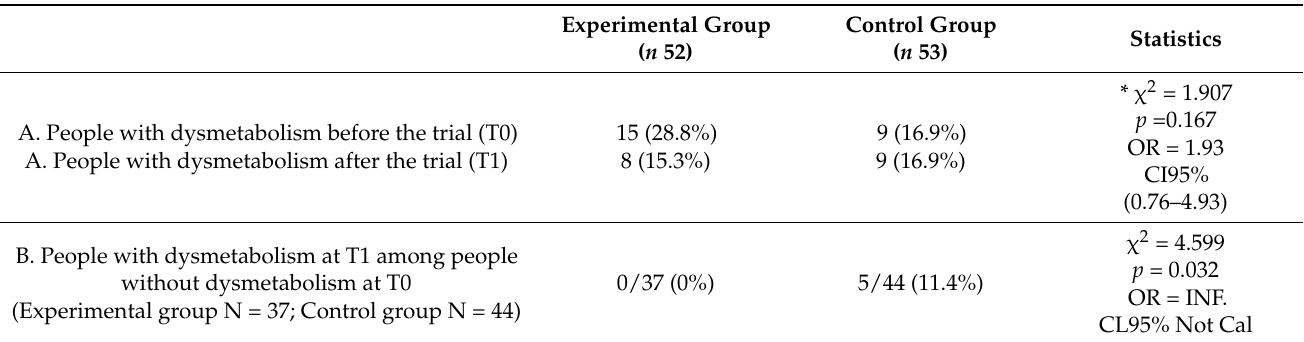
Table 2. Effectiveness of exercise in the improvement (A) and prevention (B) of dysmetabolism after the trial